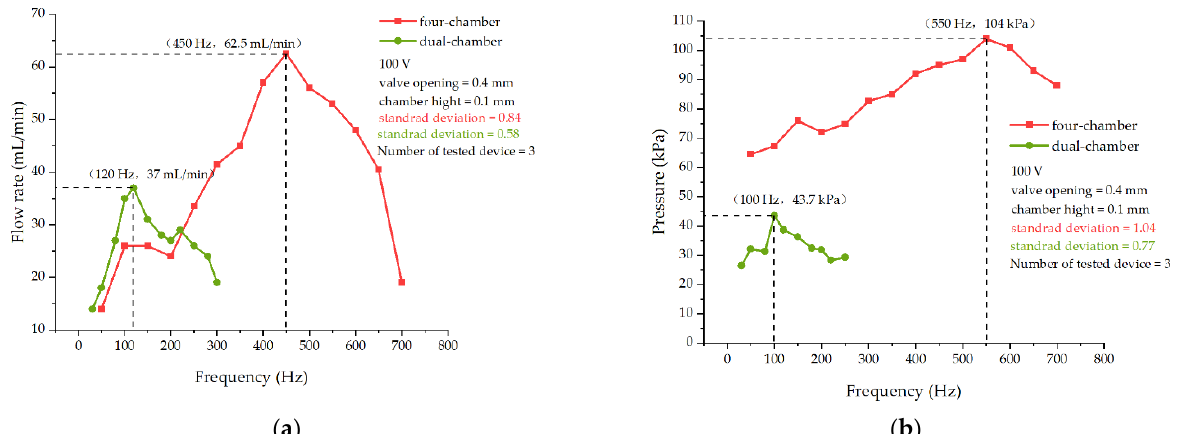
Figure 8. The relationship between the output performance of the multi-chamber series micropump vs. the frequency and voltage. ( a ) The relationship between flow rate and frequency at 100 V. ( b ) The relationship between pressure and frequency at 100 V.